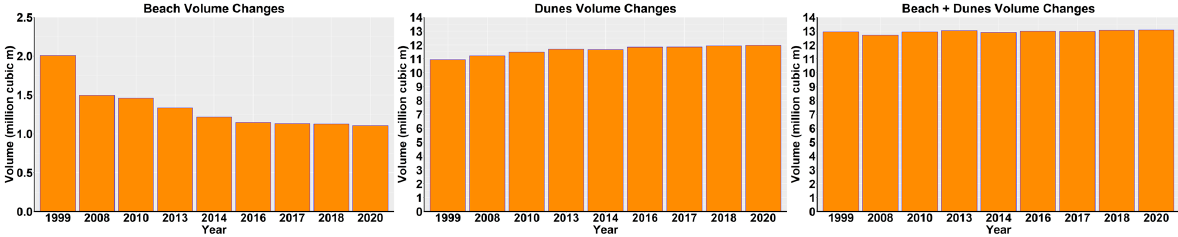
Figure 5. Volume changes in the beach and dune areas, with a sand volume loss in the beach and an increase in the volume of the dunes. This figure also shows that the volume of the entire dune system of Formby has remained